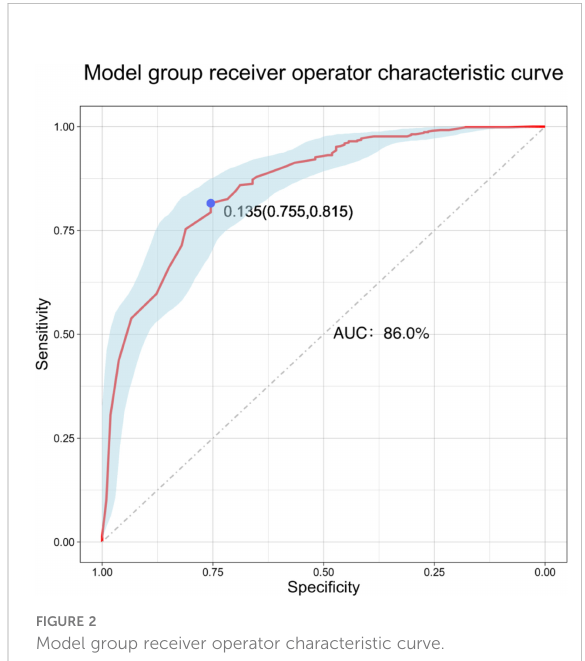
FIGURE 2 Model group receiver operator characteristic